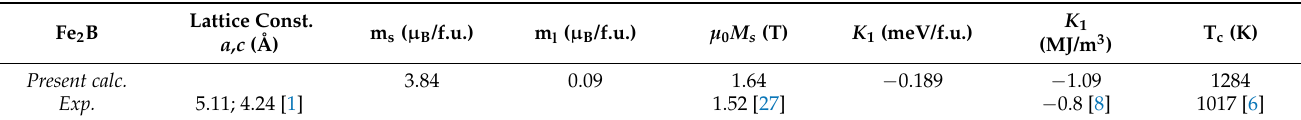
Table 1. Spin and orbital magnetic moments together with the magnetocrystalline anisotropy constant K 1 for the Fe 2 B alloy.